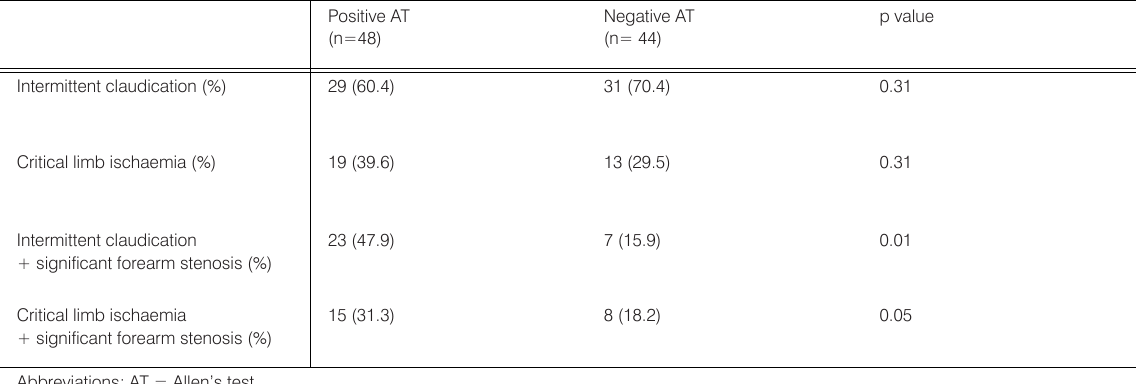
Table 2. Indications for peripheral angiography